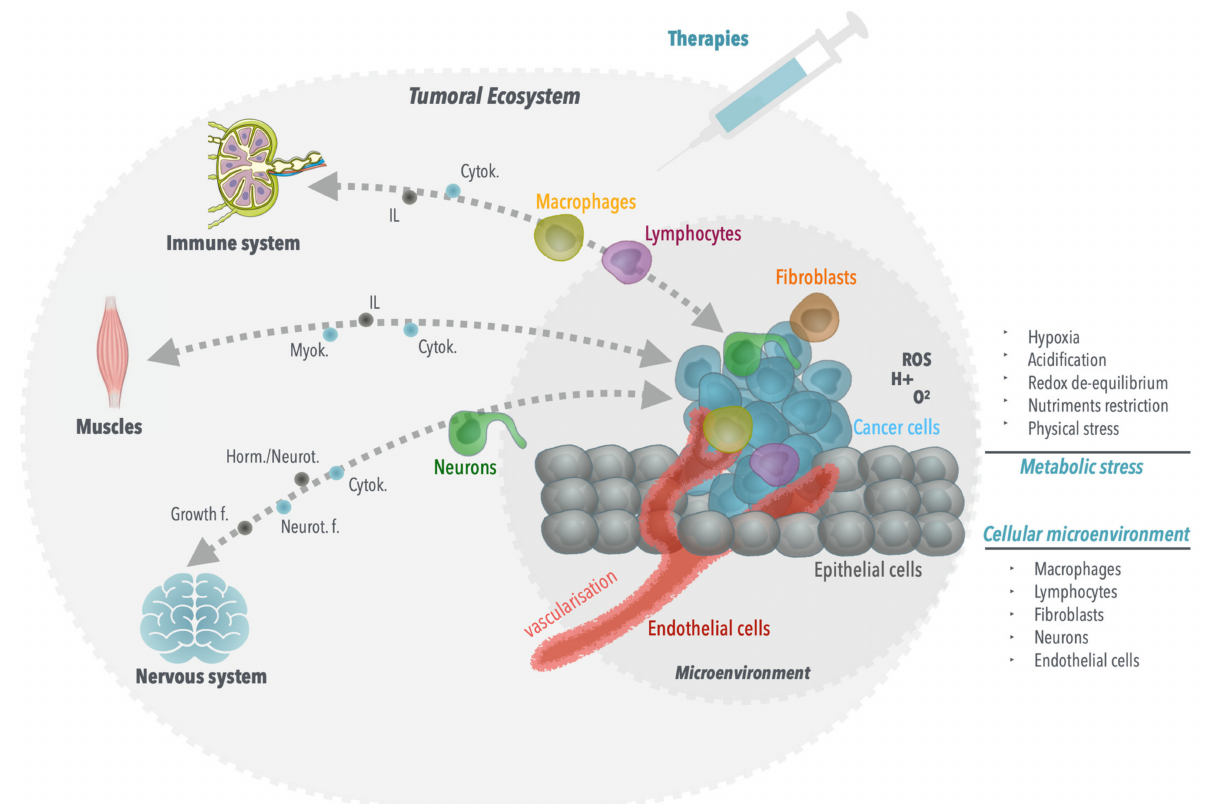
Figure 1. The tumor ecosystem. Cancer should be considered as a systemic disease as the tumor uses the entire organism for its own profit, akin to a parasite. First, upon growth, cancer cells can escape the immune system defense by inhibiting their own elimination by T-lymphocytes or M1 macrophages, while favoring the recruitment of regulatory lymphocytes and M2 macrophages, which produce tumor pro-proliferative cytokines and interleukins. These diffusible molecules produced by the tumor can negatively impact on the muscles, which in turn can also produce myokines, also impacting tumor growth. Following tumor growth, metabolic stresses, such as hypoxia, acidification, redox imbalance and nutrient deprivation drive a tumor response that induces a metabolic shift towards glycolysis and angiogenesis, through endothelial cell recruitment. In addition, in some cases, neurons or neuronal terminuses infiltrate the tumors and produce neurotrophic factors that favor tumor growth. Finally, the tumor surroundings and the multiple cellular intra-tumoral infiltrations produce a mechanical/physical stress on the tumor cells, which impacts on their behavior, resulting in their escape via metastatic